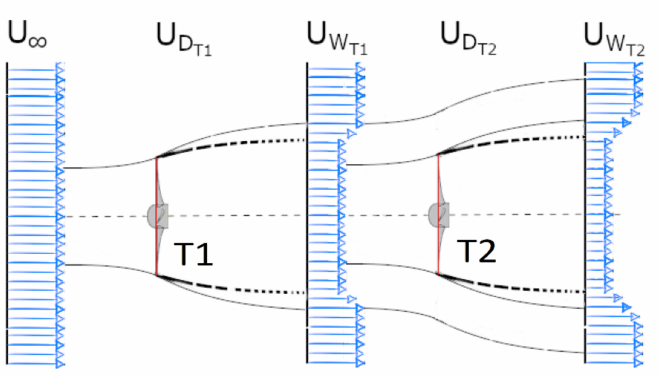
Figure 1. Two turbines in a row—one-dimensional flow theory, based on